Question: Does the figure show an increasing or a decreasing trend?
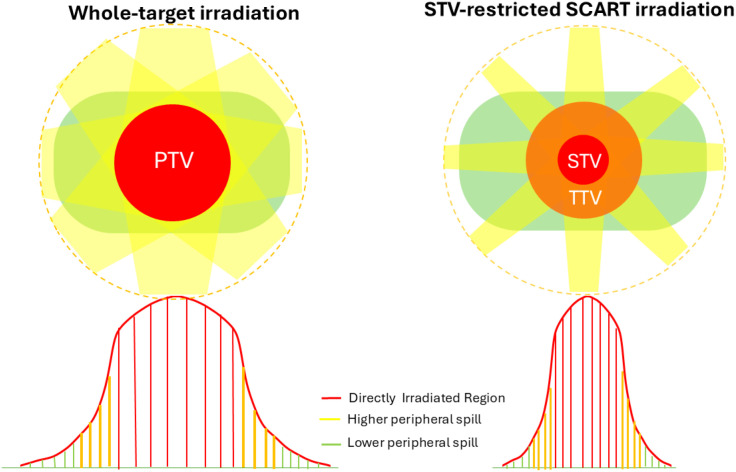
Answer: decreasing